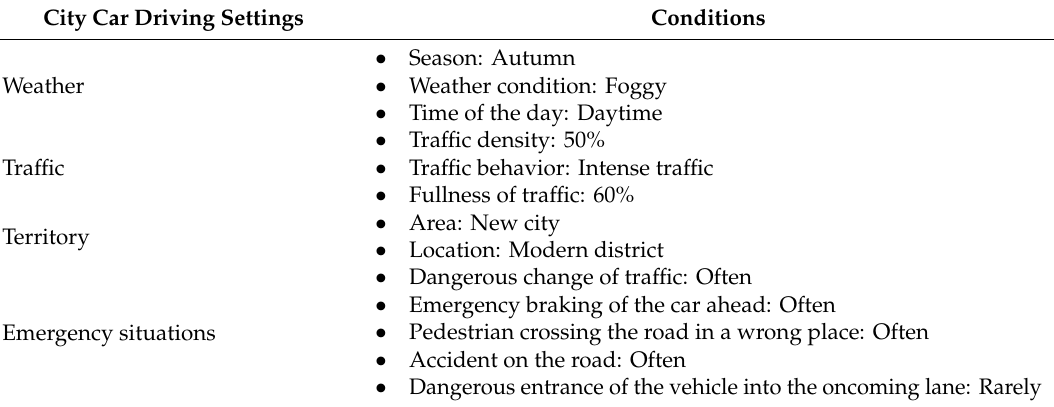
Table 1. Experimental settings of the driving software City Car Driving.